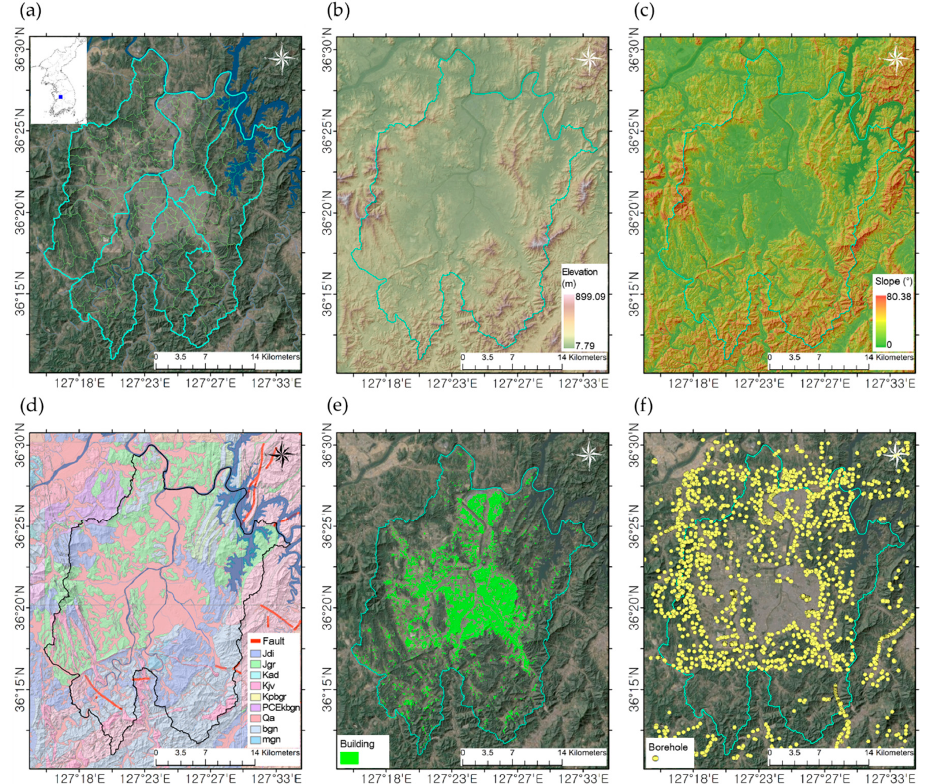
Figure 1. Testbed and geospatial database for Daejeon city: ( a ) administrative area map; ( b ) digital elevation model (5 m × 5 m) (http://map.ngii.go.kr/) [26]; ( c ) DEM-based slope map (5 m × 5 m); ( d )